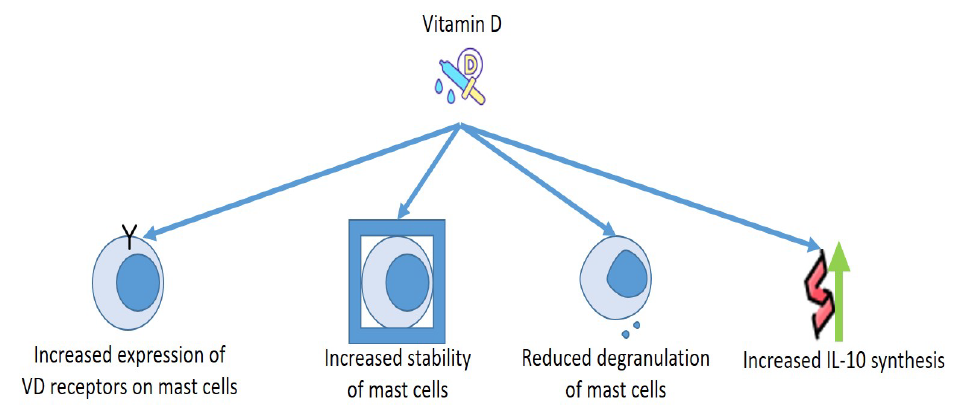
Figure 3. Effects of Vitamin D on mast